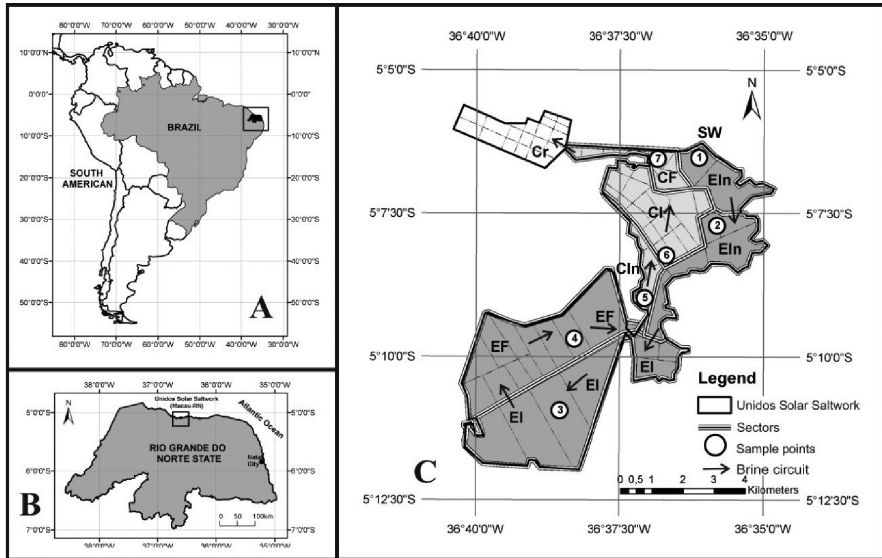
Figure 1. Map of the Salina Unidos, the ponds sampled, the direction of water/brine flow (from low to high salin- ity). Differentiation of the various types of ponds: Seawater entry pond (SW); Evaporation Zone (Initial – Ein, Intermediate – EI and Final – EF); Concentration Zone (Initial – Cin, Intermediate – CI and Final – CF) and crystallization ponds